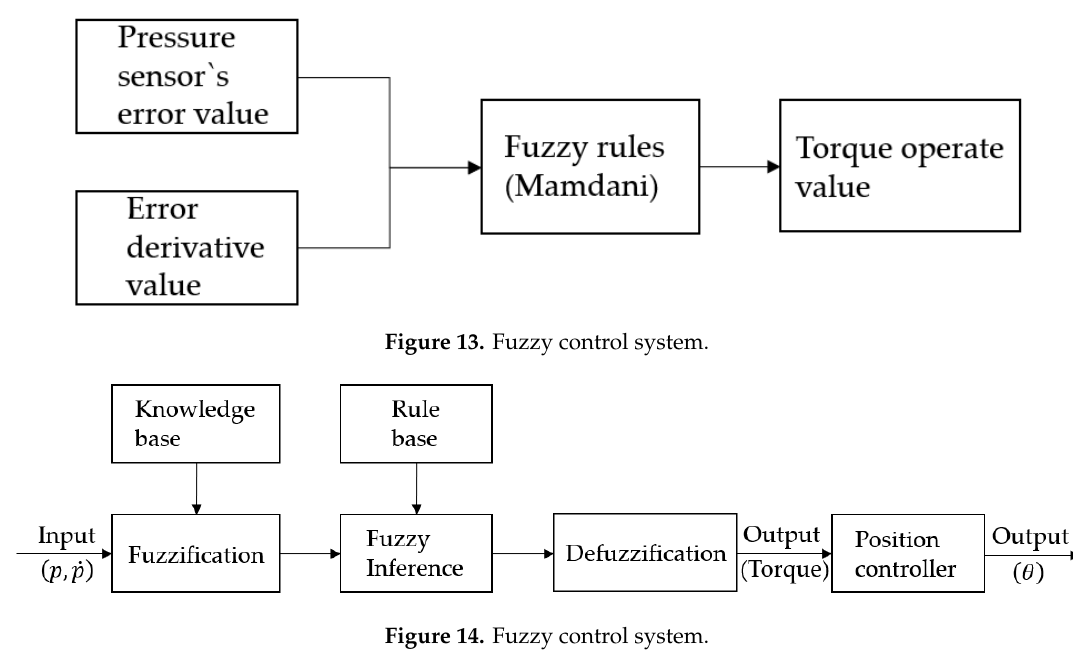
Figure 13. Fuzzy control system.